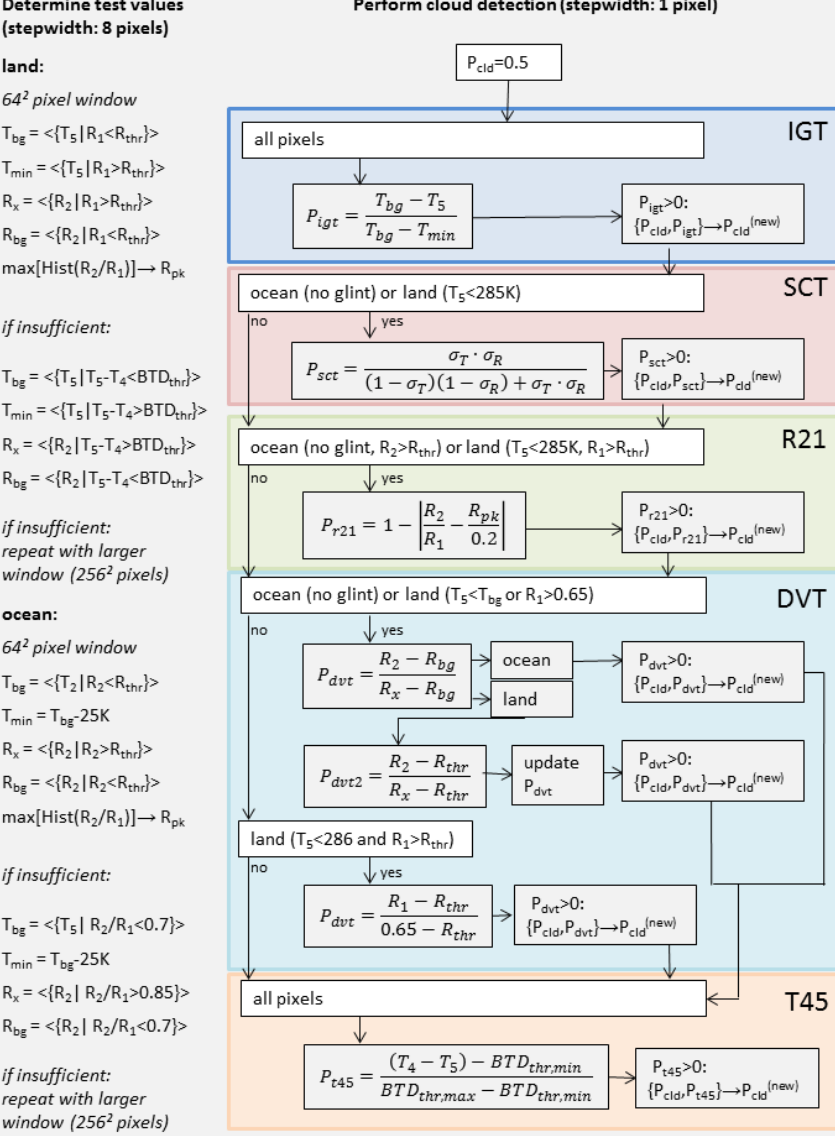
Figure 2. Flowchart of the APOLLO_NG cloud detection